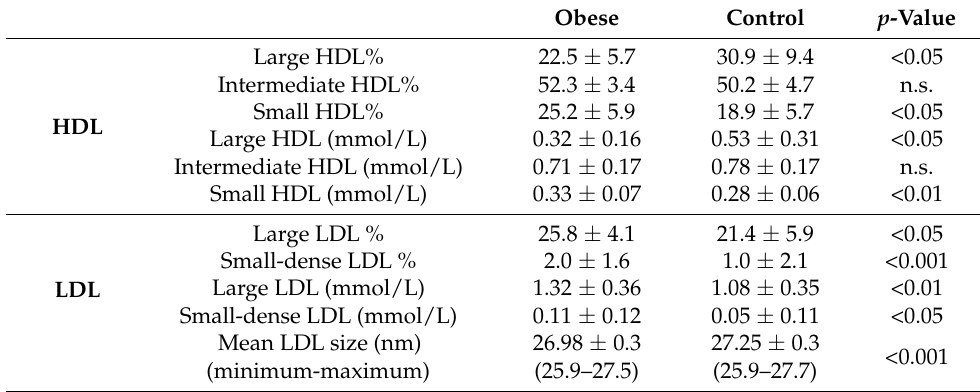
Table 2. HDL and LDL subfraction distribution and levels in obese patients and controls.